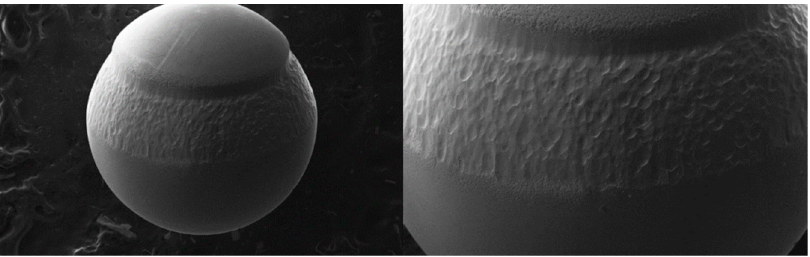
Figure 3. The damage surface topography of the valve ball.